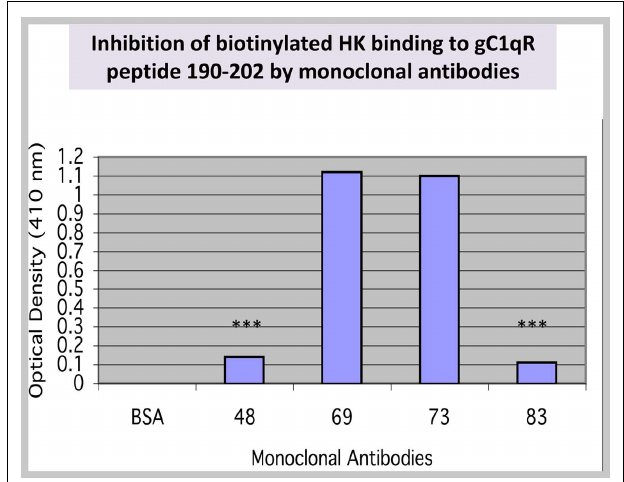
FIGURE 2 | Binding of HK to a synthetic peptide 190–202. A peptide corresponding to residues 190–202 was synthesized and purified to ≥ 95% purity. Synthetic peptide (residues 190–202) was coated (50 μ g/ml) onto duplicate microtiter wells. After blocking, the peptide was incubated with biotinylated HK in the presence or absence of mAbs. Control for non-specific HK binding was BSA.The data ( n = 2) is a representative of experiments run in duplicates and under the same conditions.The significance of data is indicated as: * p ≤ 0.05; ** p ≤ 0.01; and *** p ≤ 0.001.